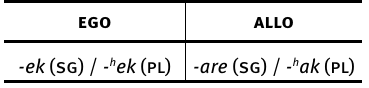
Table 3. Egophoricity in Bunan (present tense) ego